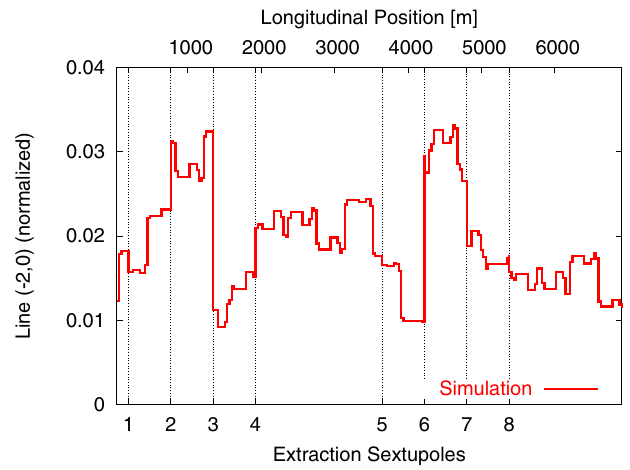
FIG. 7. (Color) Simulated amplitude of the line (cid:2)(cid:1) 2 ; 0 (cid:3) versus the longitudinal coordinate for the nominal SPS model with ex- traction sextupoles with polarities: ( (cid:5) (cid:5) (cid:5) (cid:5) (cid:1) (cid:1) (cid:1) (cid:1) 30) A. The vertical lines indicate the location of the extraction sextu-